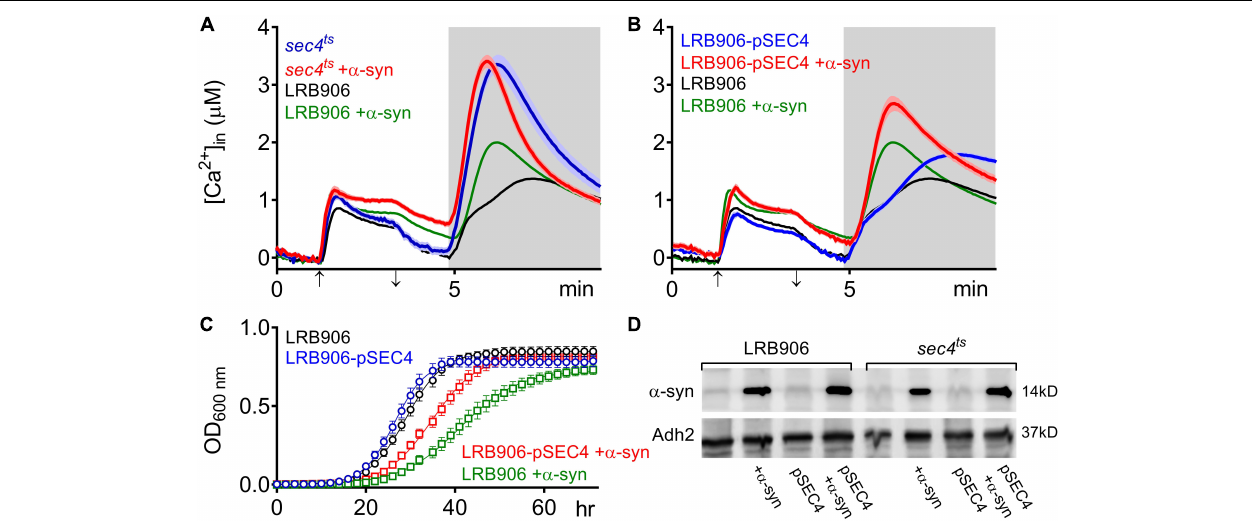
FIGURE 2 | α -Syn overexpression in SEC4 mutant cells. (A,B) Averaged Ca 2 + transient ± SEM (thin lines either side of the Ca 2 + transient trajectory) of sec4 ts (A) and LRB906 cells overexpressing SEC4 (LRB906-pSEC4) (B) with and without α -syn expression as compared to LRB906 cells at 37 ◦ C. Cells were initially perfused with Ca 2 + -free starvation medium and then transferred to a 10 mM external Ca 2 + medium for 2 min (indicated by up and down arrow on X -axis). Thereafter, cells were briefly exposed to Ca 2 + -free intracellular medium prior to membrane permeabilization using Triton X-100 (indicated by light gray zone). (C) Growth curves based on OD 600 density measurements at 25 ◦ C. Strains analyzed include LRB906 (black), LRB906 overexpressing SEC4 (LRB906-pSEC4 – blue), LRB906 overexpressing α -syn (LRB906 + α -syn – green) and LRB906 overexpressing SEC4 and α -syn (LRB906-pSEC4 + α -syn – red). Each time point represents the average ± SEM of triplicate cultures. (D) Western blot of control LRB906 cells and cells overexpressing SEC4 (pSEC4) with and without α -syn overexpression (first 4 lanes), and control sec4 ts cells and cells overexpressing SEC4 with and without α -syn overexpression (last 4 lanes). Immunodetection was performed using primary antibodies directed against α -syn or Adh2 as indicated on the left. Molecular weight markers are indicated on the right.